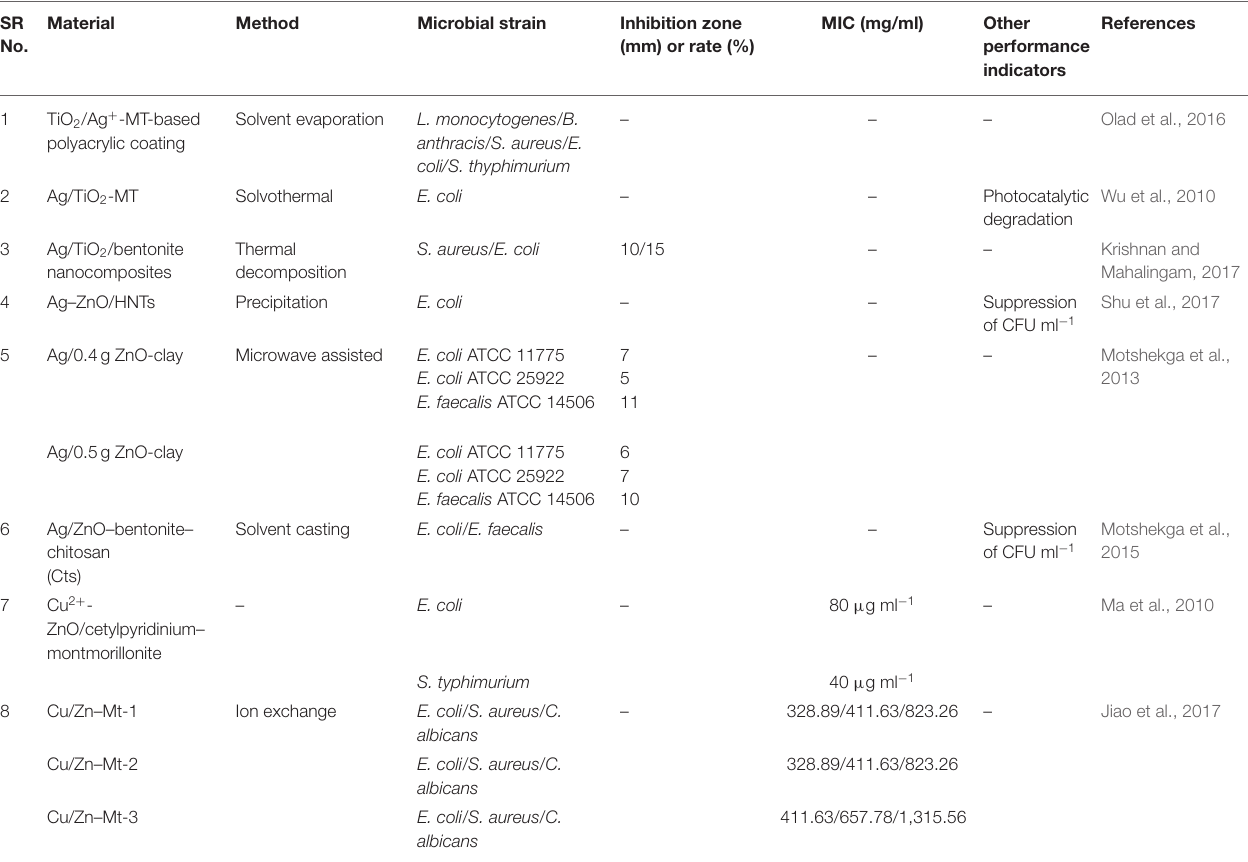
TABLE 2 | Types and antimicrobial properties of clay-supported bimetallic nanoparticles. SR No.